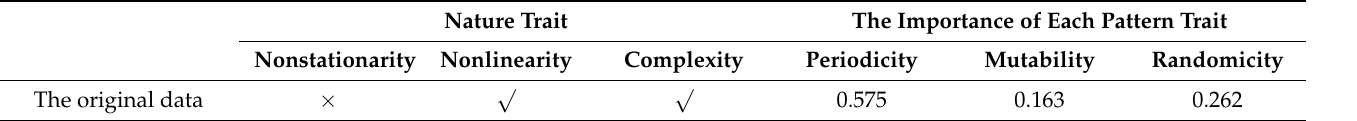
Table 1. Cyclicity test results of original time series data.